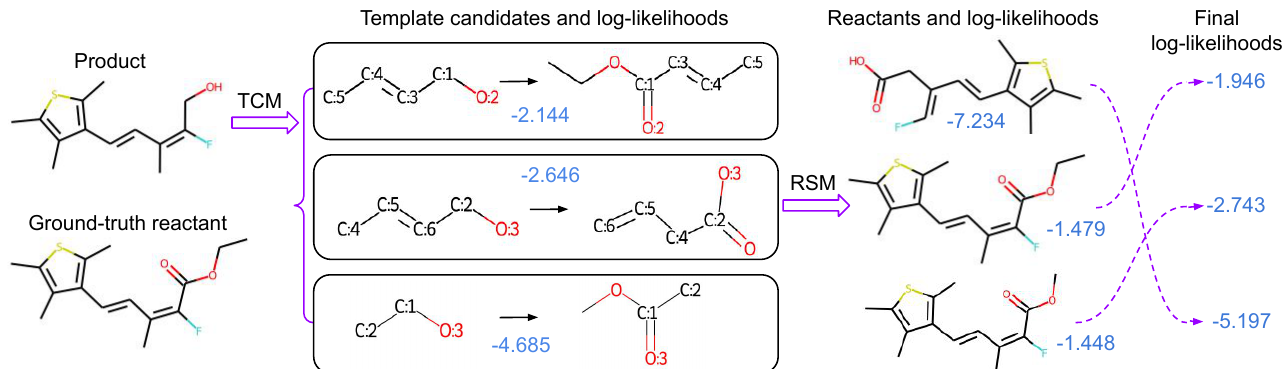
Figure 2. The overall pipeline of our proposed method. Given the desired product as shown at the top left, single-step retrosynthesis finds the ground-truth reactant as shown at the bottom left. Numbers indicated in blue are the corresponding log-likelihoods of our models, and the log-likelihoods of the template composer model (TCM) and the reactant scoring model (RSM) are combined to obtain the final ranking of the reactants. In this example, combining log-likelihoods of TCM and RSM helps to find the correct Top-1 reactant.